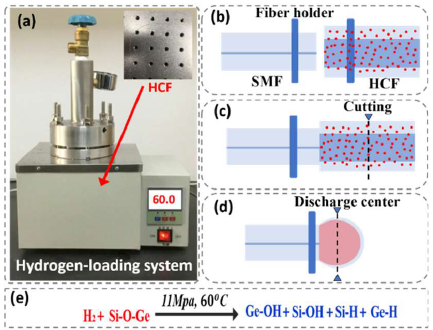
Figure 1. ( a – d ) Fabrication process of the proposed sensor and ( e ) equation.